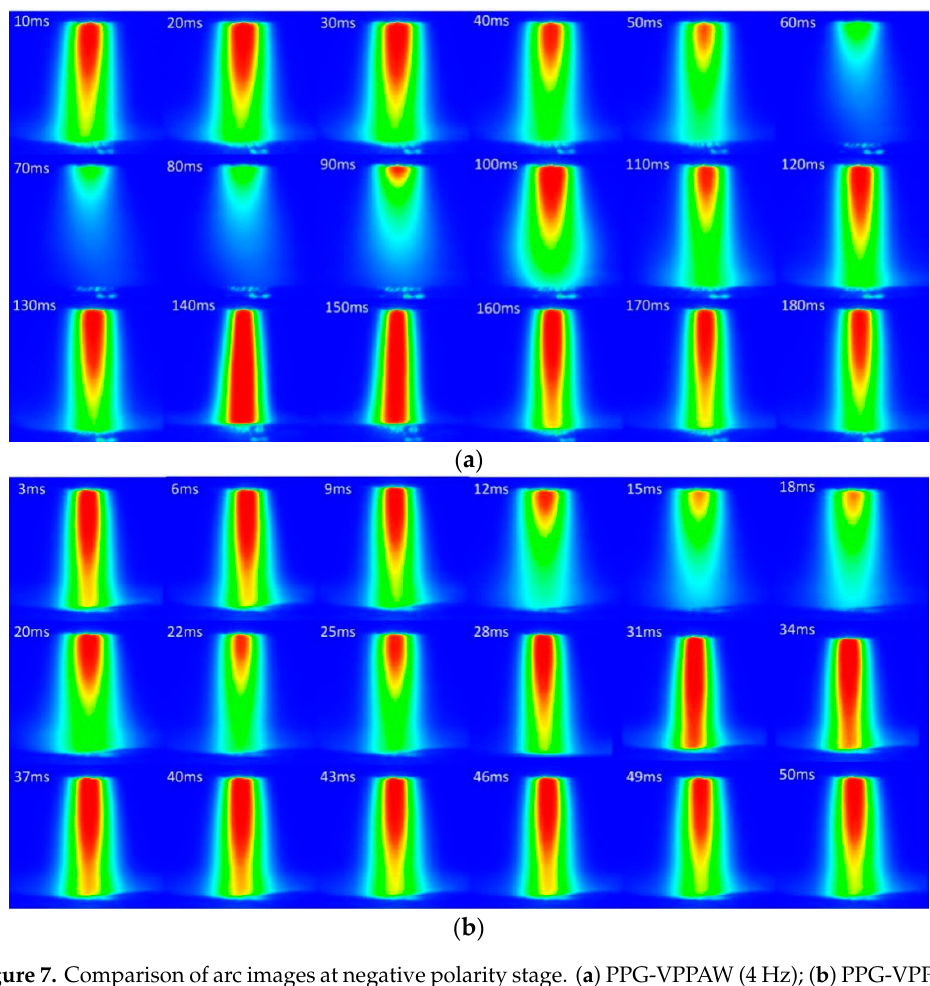
Figure 7. Comparison of arc images at negative polarity stage. ( a ) PPG-VPPAW (4 Hz); ( b ) PPG-VPPAW (20 Hz). (The color bar of this figure is same as Figure 6).